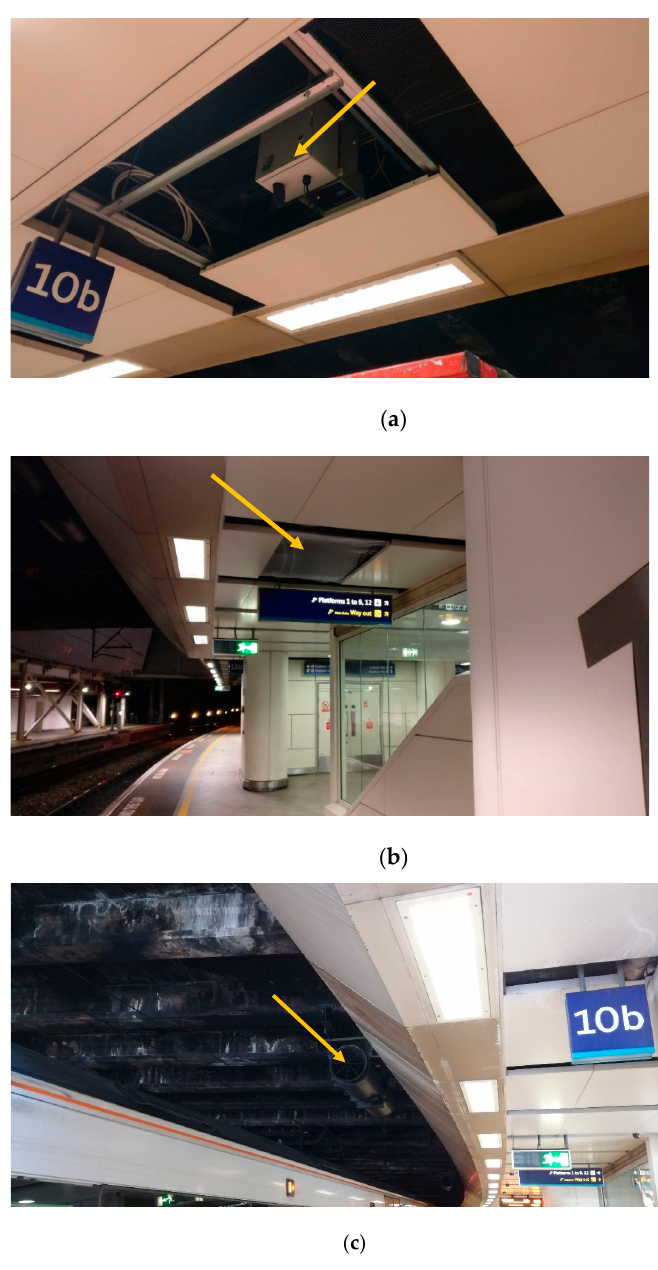
Figure 2. ( a ). Location of Praxis monitor on Platform 10B (photo: [12]). ( b ). Installation of Praxis monitor on Platform 11B in roof panelling of station (photo: [12]). ( c ). Example of one of 98 bi-directional impulse jet fans on Platform 10B installed above track level at 5 m (photo: M. Clegg, 2020).